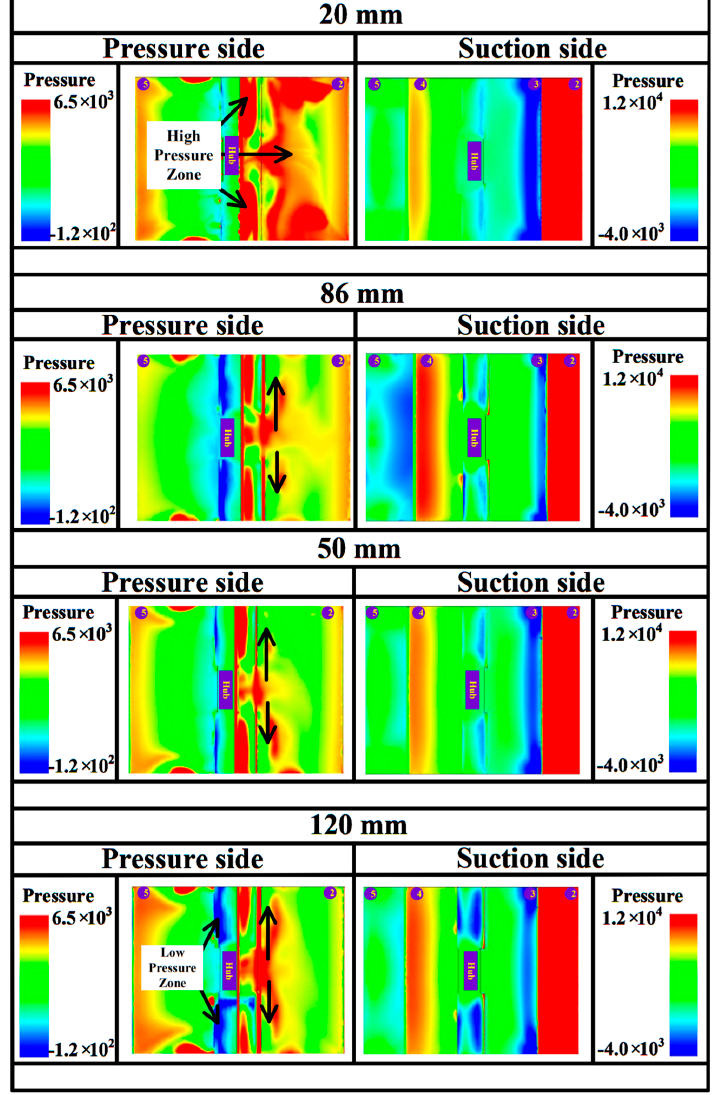
Figure 11. Pressure distribution on water wheels from bird’s eye views of the pressure side and suction side under different clearance configurations.